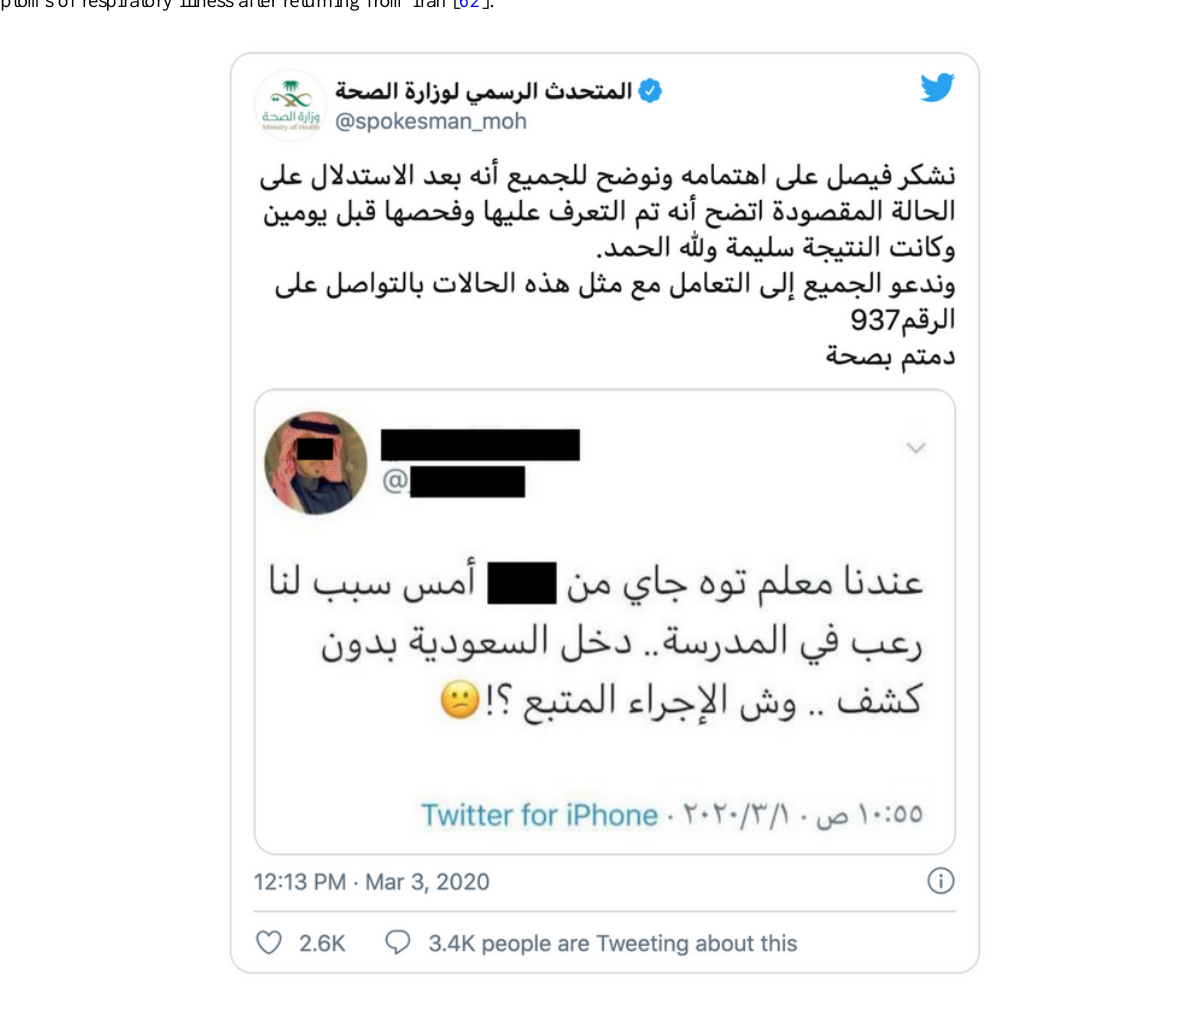
Figure 4. Twitter reply by the Saudi Ministry of Health spokesperson to a tweet by a person who was concerned about a colleague who showed symptoms of respiratory illness after returning from Iran